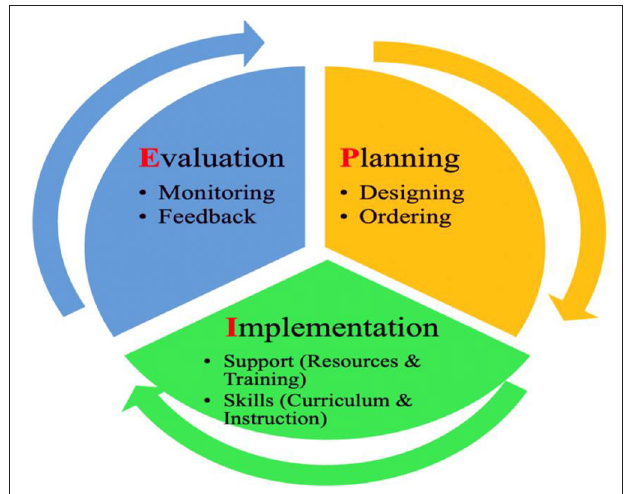
FIGURE 1 | PIE education planning